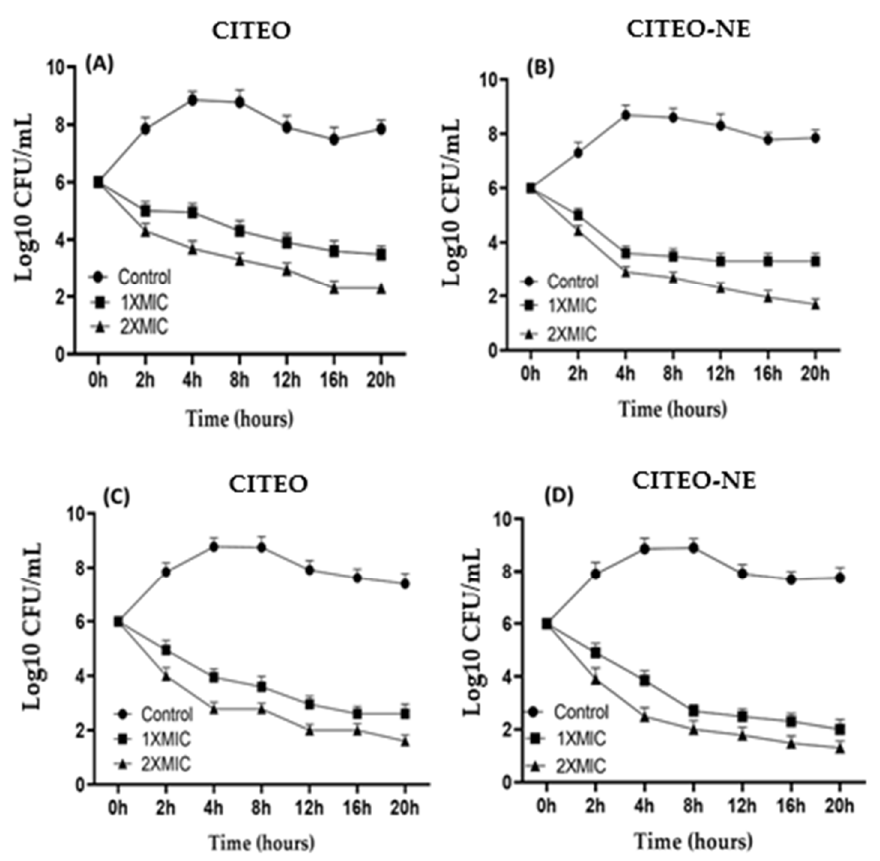
Figure 4. Time-killing assays of ( A ) CITEO against S. aureus , ( B ) CITEO-NE against S. aureus , Figure 4. Time ‐ killing assays of ( A ) CITEO against S. aureus , ( B ) CITEO ‐ NE against S. ( C ) CITEO against C. albicans and ( D ) CITEO-NE against C. albicans aureus , ( C ) CITEO against C. albicans and ( D ) CITEO ‐ NE against C. albicans .